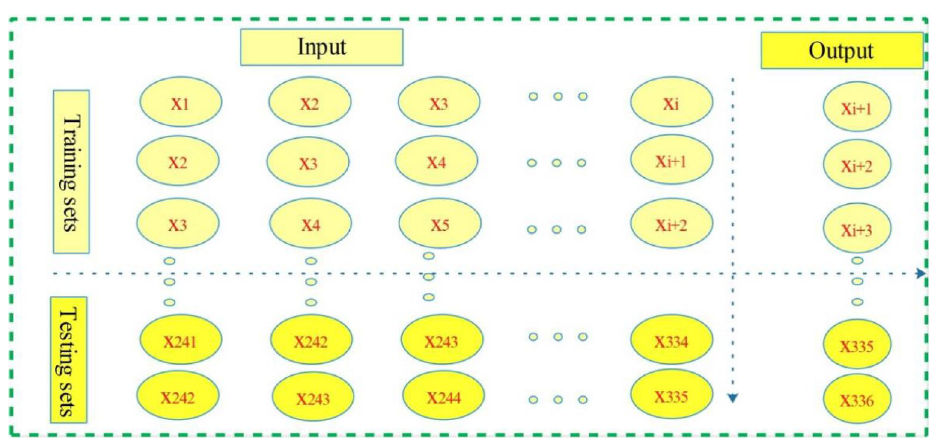
Figure 1. The schematic diagram of LS